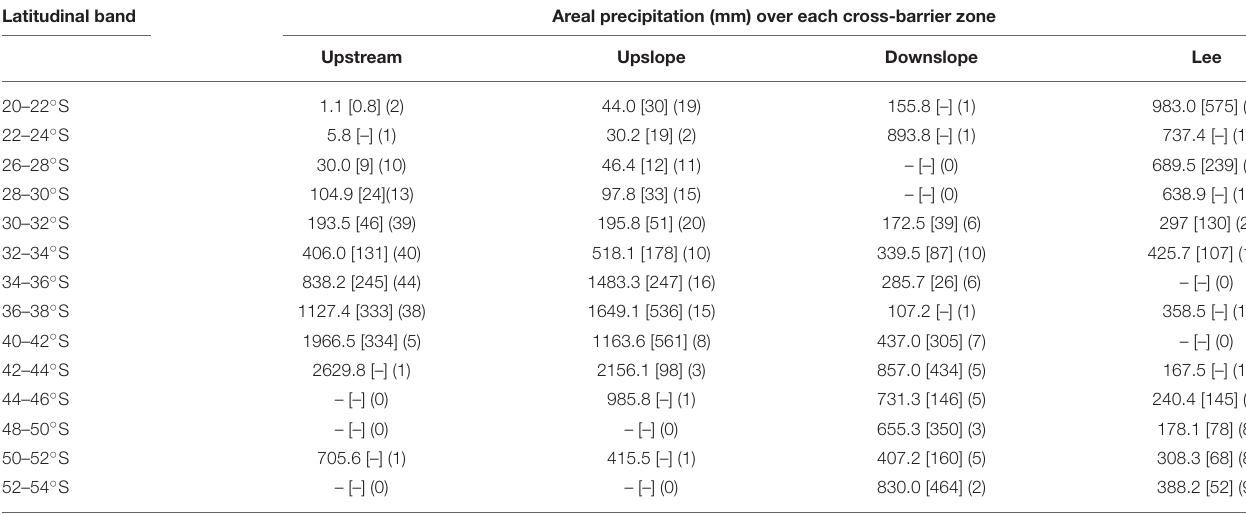
TABLE 1 | Areal average of annual mean precipitation for the different cross-barrier zones and latitudinal bands shown in Figures 3 , 4 . Latitudinal band Areal precipitation (mm) over each cross-barrier zone Upstream Upslope Downslope